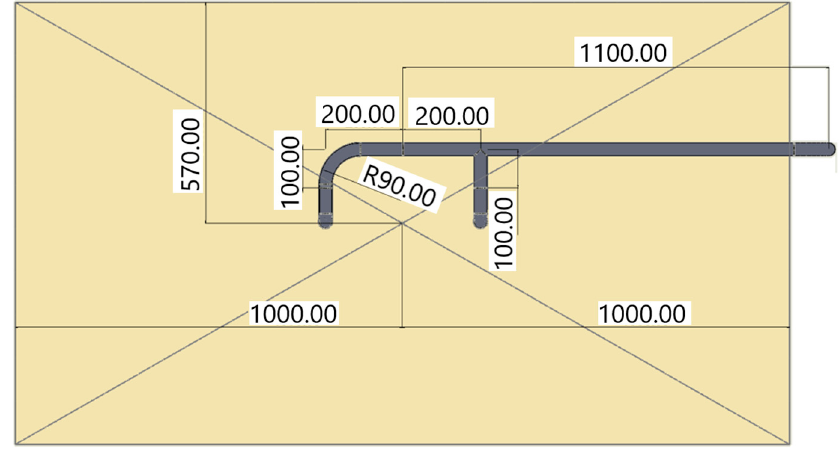
Figure 1. Assembly drawing of an adiabatic cooler top view.